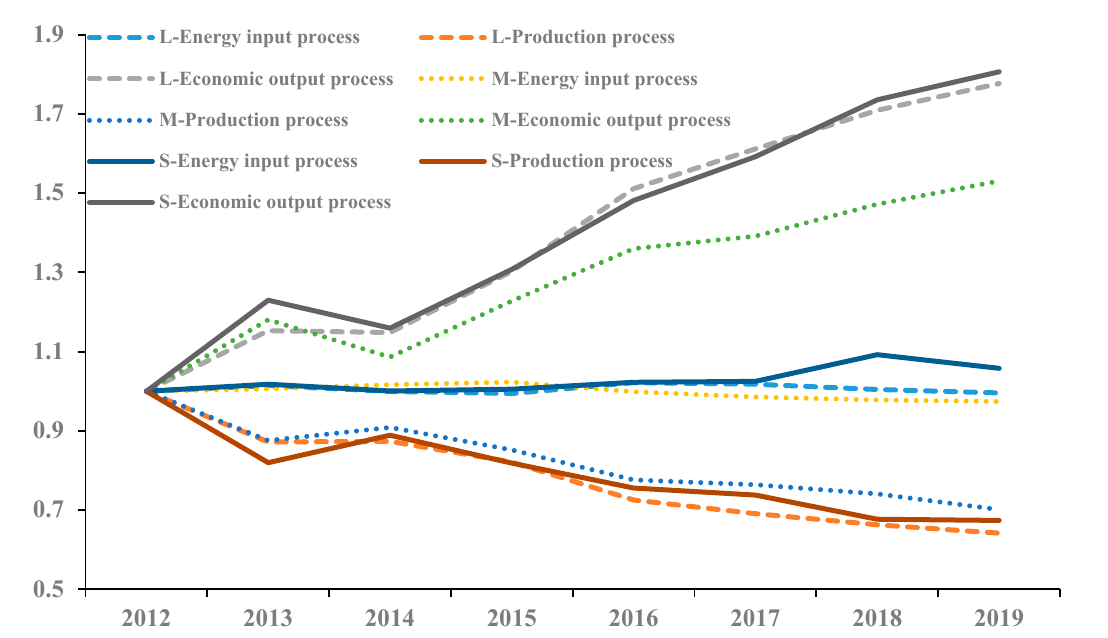
Figure 6. The cumulative decomposition results for the sample countries’ carbon emission change by processes of the different groups,